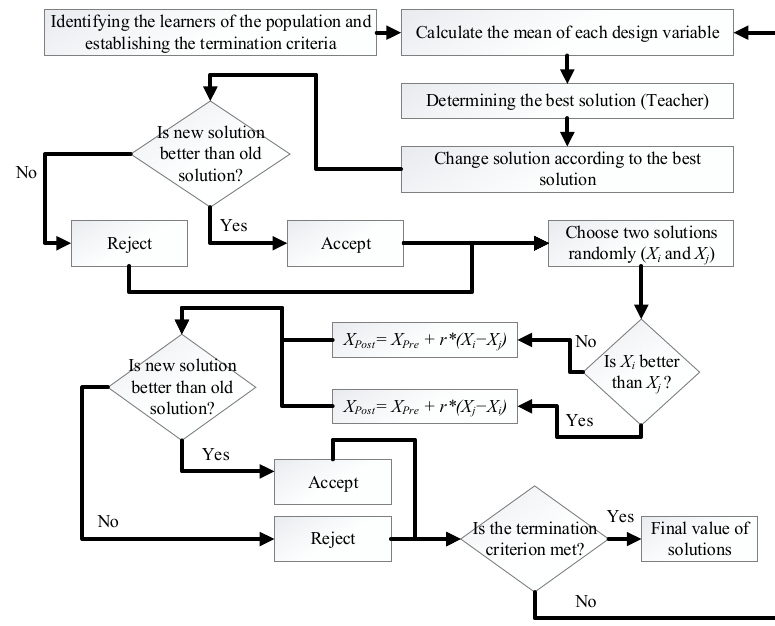
Figure 1. Teaching learning-based optimization flowchart [26].